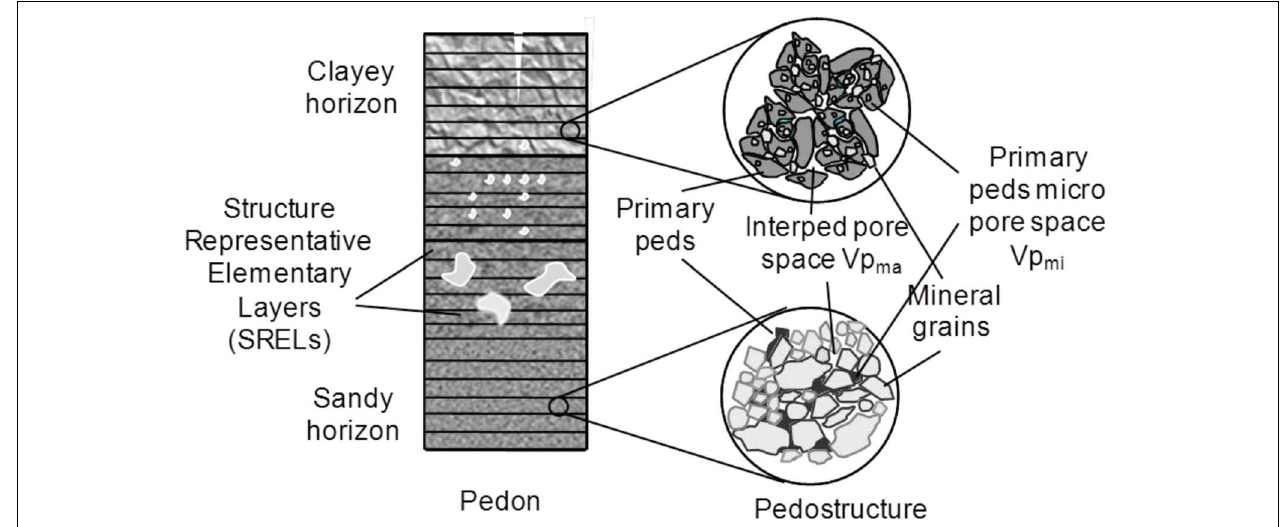
FIGURE 2 | Representation of the internal organization of the pedon, hierarchized into its hydro-functional levels of organization: horizons, pedostructure, primary peds after Braudeau et al.